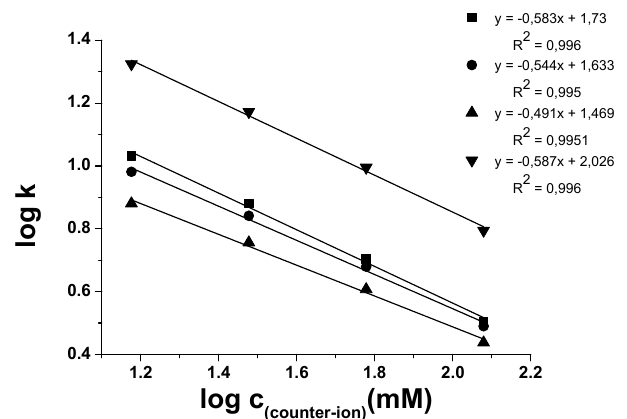
Figure 8. Effects of counter-ion concentration of selected analytes on retention factor, k 1. Chromatographic conditions: columns, QN-AX™; mobile phase, CO 2 /MeOH (60/40 v/v ) containing TEA/FA in concentration 7.5/15.0, 15.0/30, 30/60 and 60/120 mM/mM; flow rate, 2.0 mL·min − 1 ; T col , 40 ° C; back pressure, 150 bar; detection, 262 nm. Symbols: for Fmoc-Asp(O t Bu)-OH; for Fmoc-Phe-OH; for Fmoc-Leu-OH; and for Fmoc-Lys(Boc)-OH.